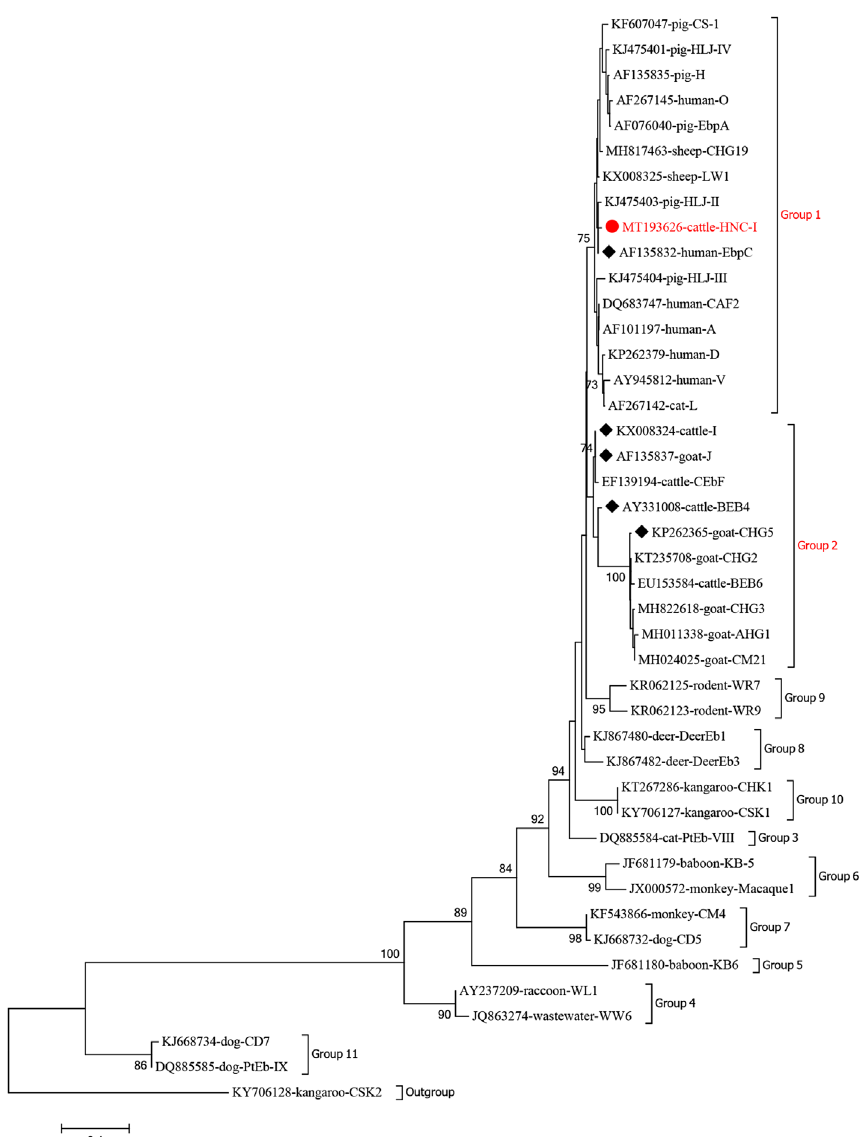
Figure 2. Phylogenetic tree based on neighbor-joining (N-J) analysis of ITS sequences. Phylogenetic relationships between the E. bieneusi genotypes identi fi ed in cattle here and other known genotypes deposited in GenBank were inferred by an N-J analysis of ITS sequences based on genetic distance by the Kimura two-parameter model. The numbers on the branches are percent bootstrapping values from 1000 replicates. Each sequence is identi fi ed by its accession number, host origin, and genotype designation. Enterocytozoon bieneusi genotype CSK2 (KY706128) was used as the outgroup. The squares and triangles fi lled in black indicate novel and known genotypes identi fi ed in this study,